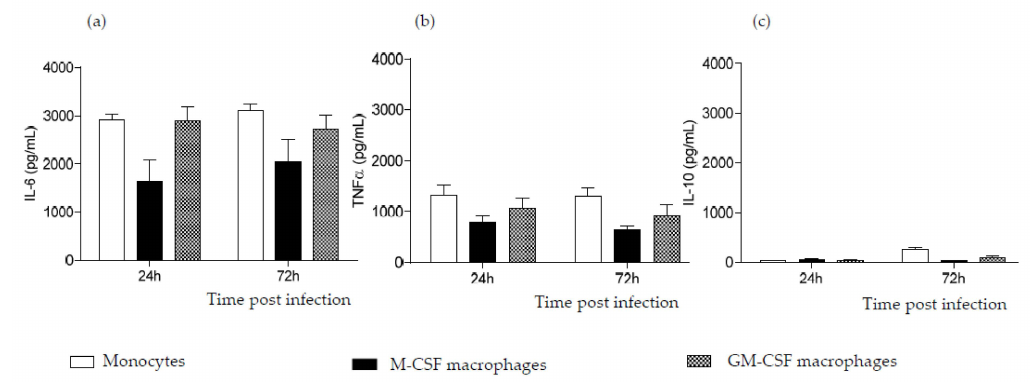
Figure 4. CVB4 can induce pro-inflammatory cytokines in monocyte-derived macrophages (MDM). Monocytes and MDM induced with M-CSF (M-CSF macrophages) or GM-CSF (GM-CSF macrophages) for seven days were inoculated with CVB4. Supernatants were collected at 24 and 72 h post-infection (pi). IL-6 ( a ), TNF α ( b ) and IL-10 ( c ) were measured in supernatants by using ELISA. These results are the mean ˘ SEM of three independent